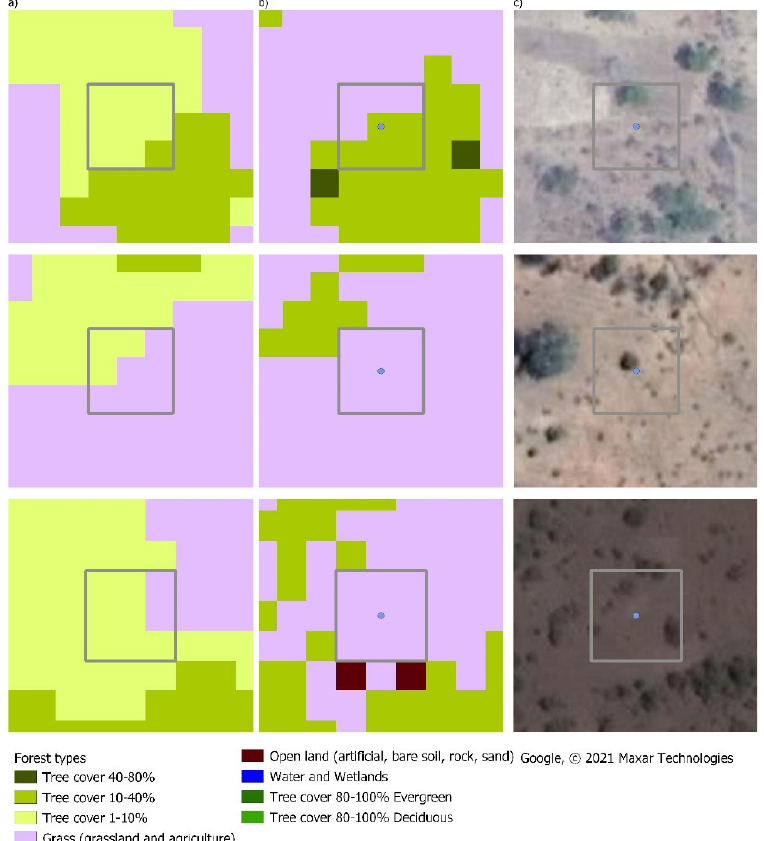
Figure 12. Illustration of the class 21 1–10% tree cover for ( a ) the window–forest type classes ETC, ( b ) the pixel–forest type classes RF and ( c ) recent VHR images in Google Earth.